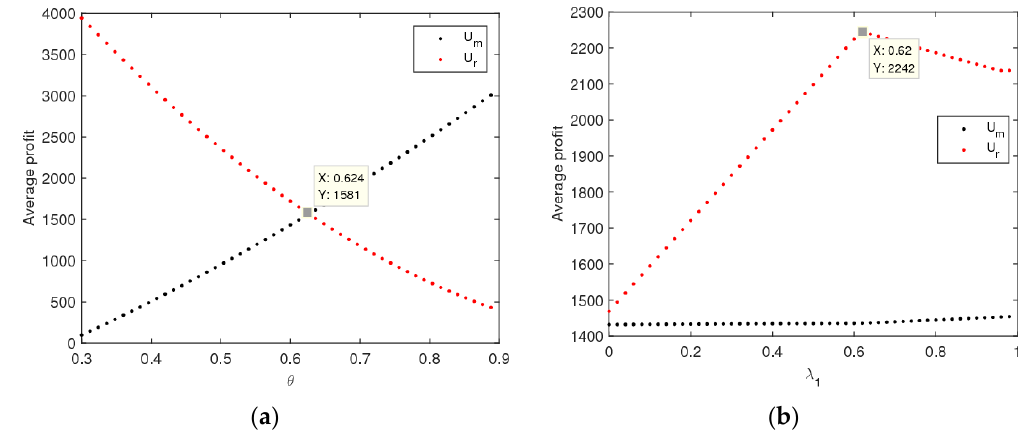
Figure 14. The effect of parameters changing on the utilities of the manufacturer and retailer with 𝛼 (cid:2869) = 𝛼 (cid:2870) = 0.008 . ( a ) 𝜃 , ( b ) 𝜆 (cid:2869) .